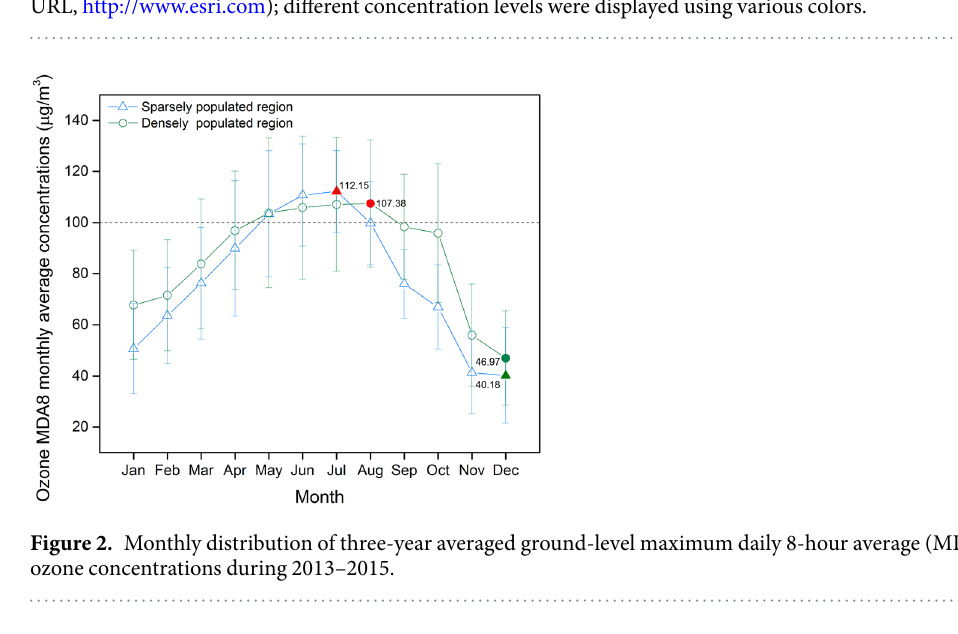
95% Confidence interval of the Difference